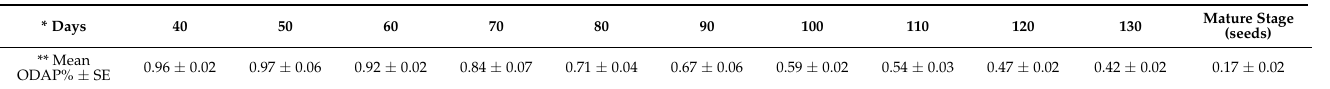
Table 3. Mean total ODAP content during different plant development stages in five accessions of grass pea during 2010–11.